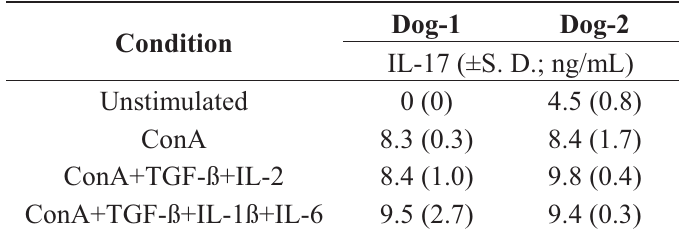
Table 2. IL-17 Production by ConA-Stimulated PBMC a